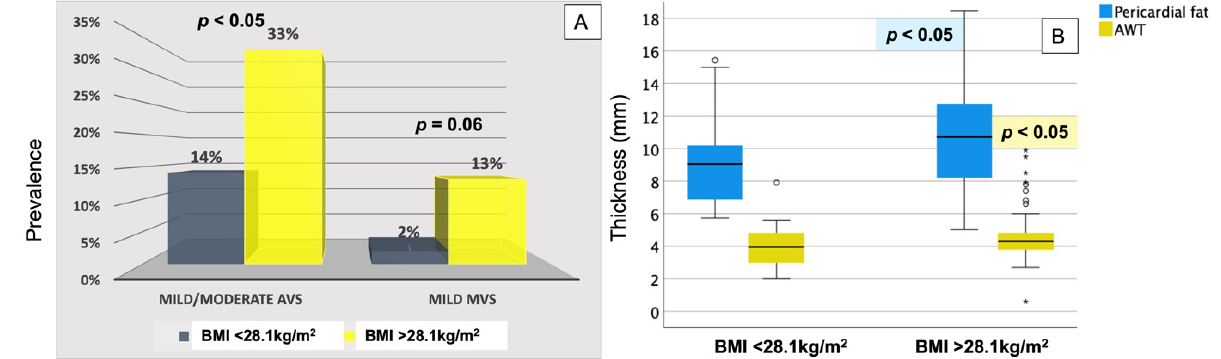
Figure 3. One-year postoperative AVS and MVS (percentages, panel ( A )), and pericardial fat thickness and AWT (in mm, data presented as boxplots in panel ( B )) in patients with lower vs. higher than the median achieved BMI of 28.1 kg/m 2 . p values of significance for comparison of each marker of atherosclerosis between the two groups.